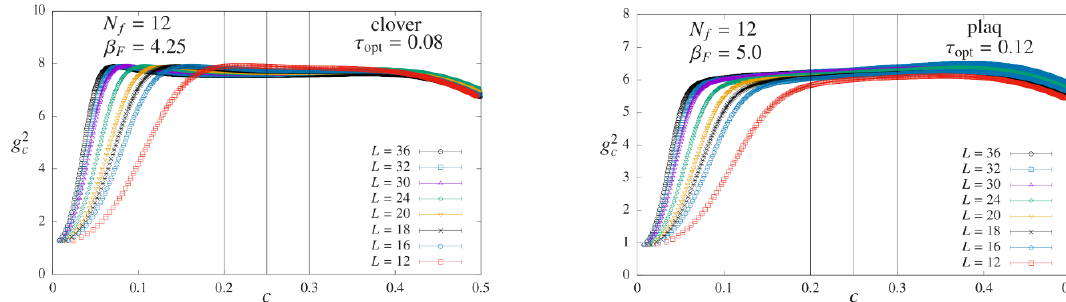
p Figure 12 . Renormalized couplings g 2 ( L ) vs. the (cid:12)nite-volume gradient (cid:13)ow scale c = 8 t=L for e c all eight L 4 lattice volumes we study. Two representative values of (cid:12) F are considered, (cid:12) F = 4 : 25 for the clover discretization of the energy density (left) and (cid:12) F = 5 for the plaquette discretization (right). Lattice artifacts are non-negligible in the initial rise of the coupling from c = 0, and for L = 12 it is not clear whether this initial rise is complete for c = 0 : 2. Larger values of L are not a(cid:11)ected by this issue at c = 0 : 2, while larger c (cid:21) 0 : 25 are needed for L = 12, in agreement with the other results discussed in the text. Vertical lines mark the c = 0 : 2, 0.25 and 0.3 that we